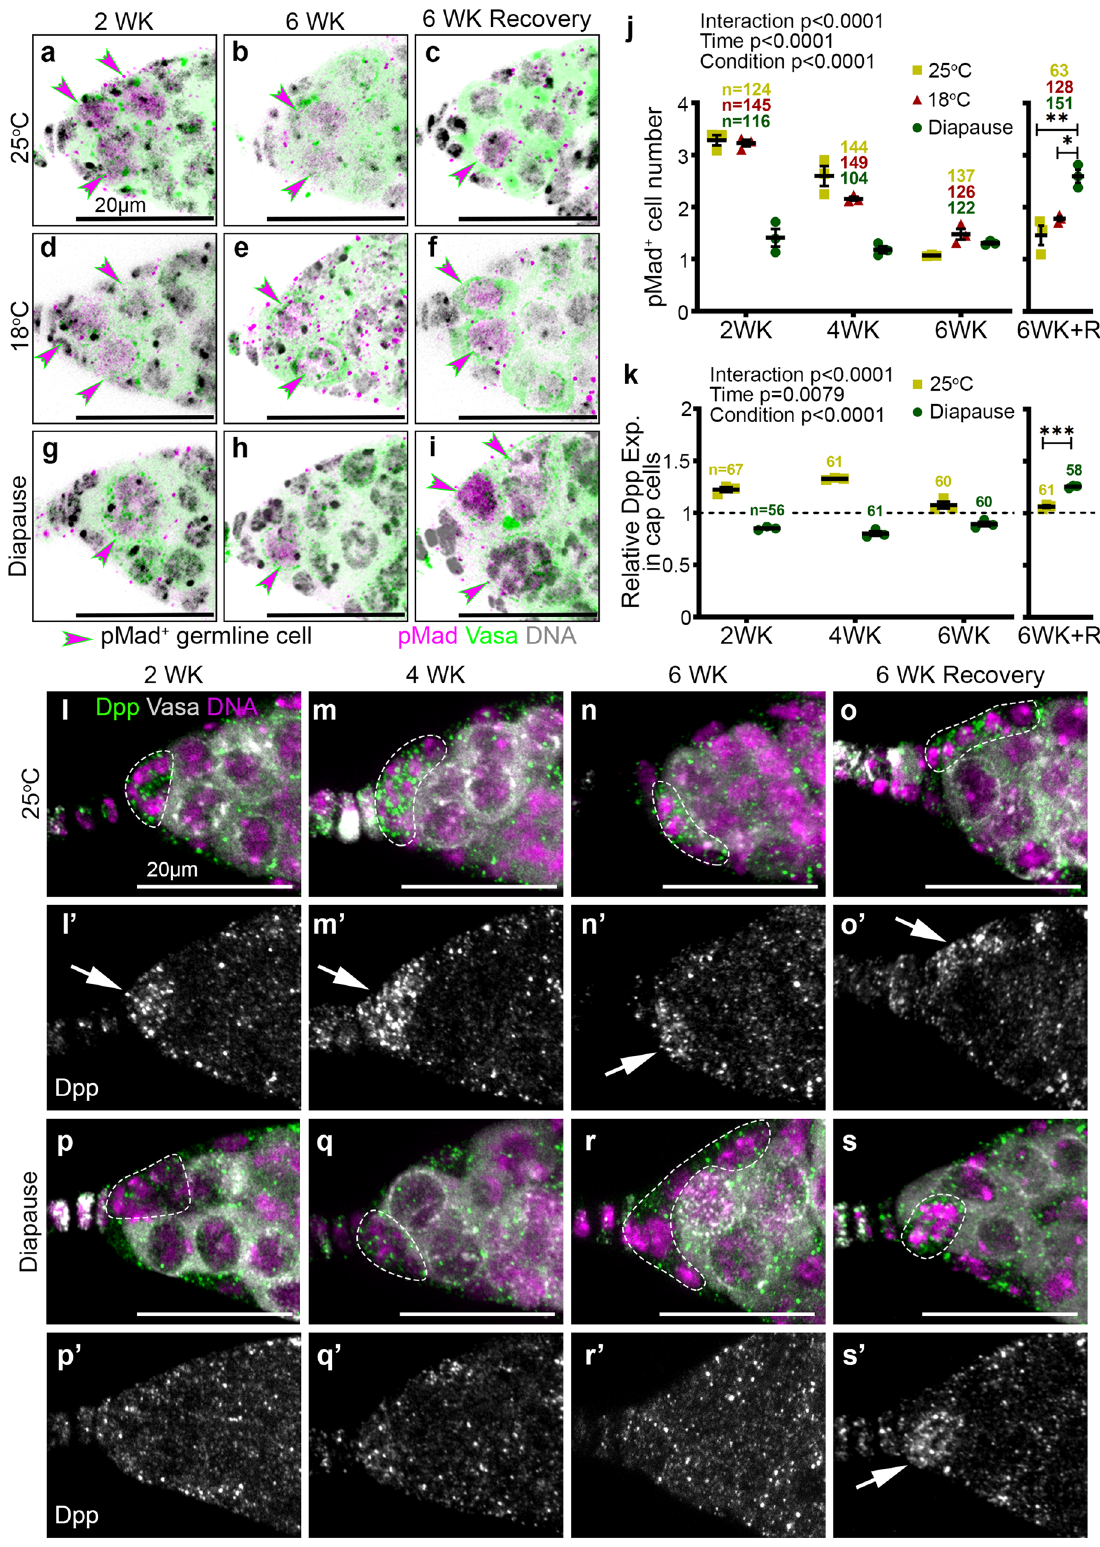
and Hts-negative 16-cell cysts were present, though arrested (Supplementary Fig. 7l). Upon recovery, multicellular cysts reappeared along with GSCs (Supplementary Fig. 7m). These results suggest that the few remaining dAnillin-positive germ cells represent a pool from which GSCs may rebound post-diapause to produce developing